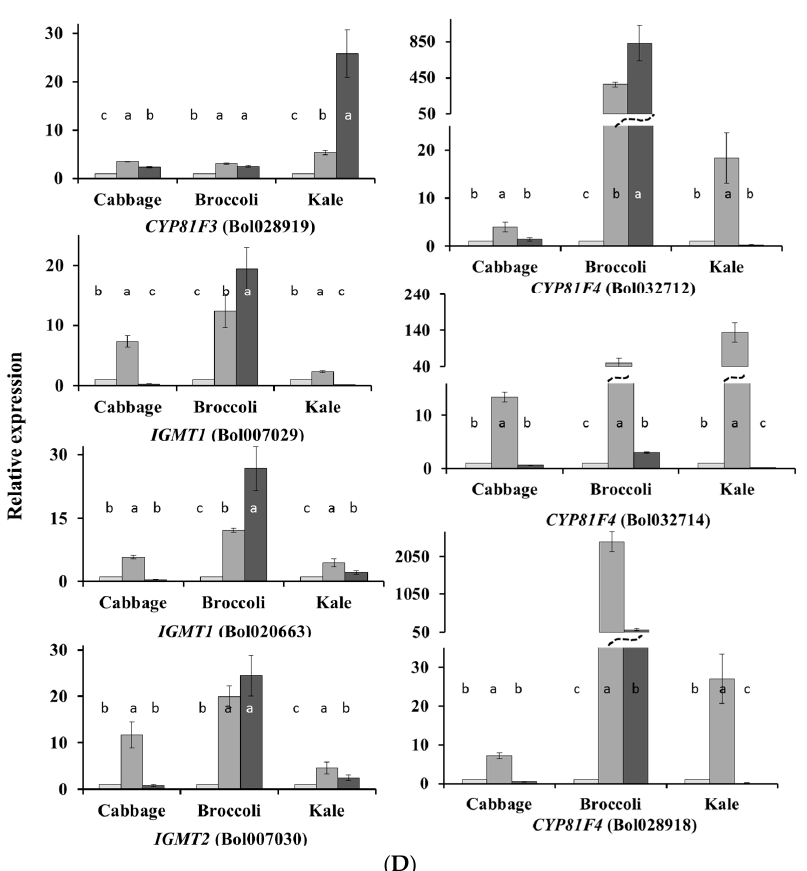
Figure 2. Quantitative PCR analyses of the expression of glucosinolate biosynthesis genes under the exogenous application of MeJA and SA. Expression was normalized to that of actin and the values in the control plants were set to 1. Each data point is the average for each of the three biological replicates with three technical replicates against each biological replicate. Vertical bars indicate standard deviation of the means. Different letters indicate statistically significant difference ( p < 0.01). ( A ) Relative expression analyses of five aliphatic transcription factor-related genes; ( B ) Relative expression analyses of six indolic transcription factor-related genes; ( C ) Relative expression analyses of 10 aliphatic glucosinolate biosynthesis-related genes; ( D ) Relative expression analyses of 17 indolic glucosinolate biosynthesis-related genes.